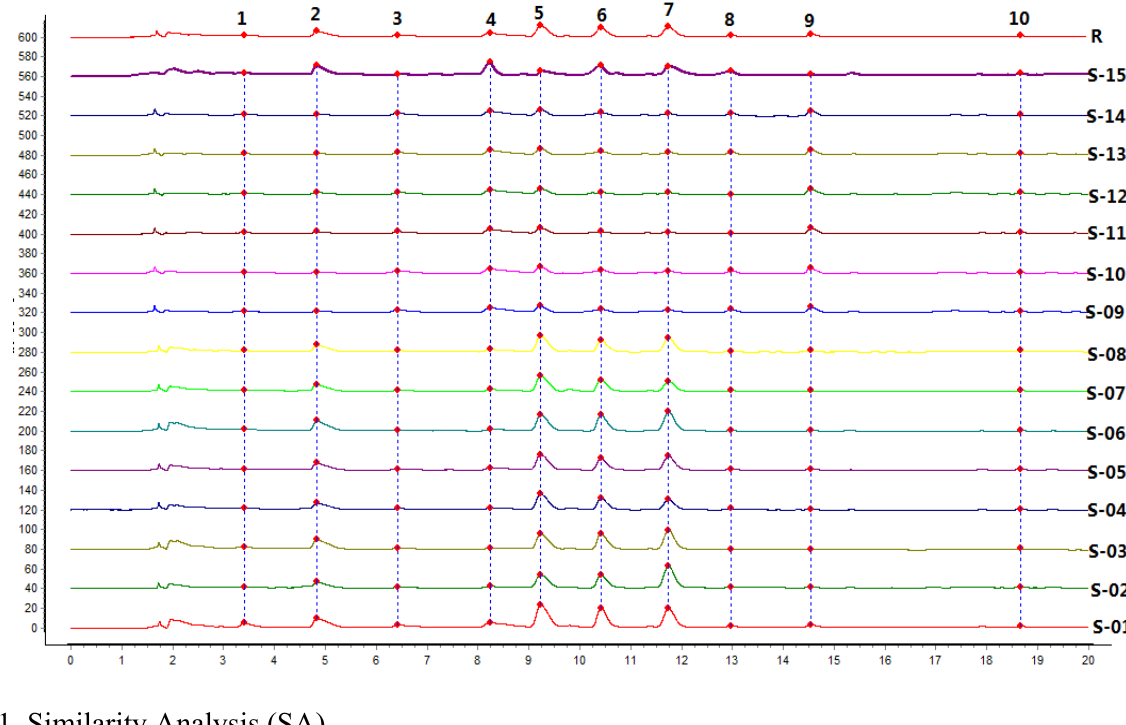
Figure 3. Ultra-performance liquid chromatography (UPLC) fingerprint chromatograms of 15 batches of Radix Isatidis (R: digital standard